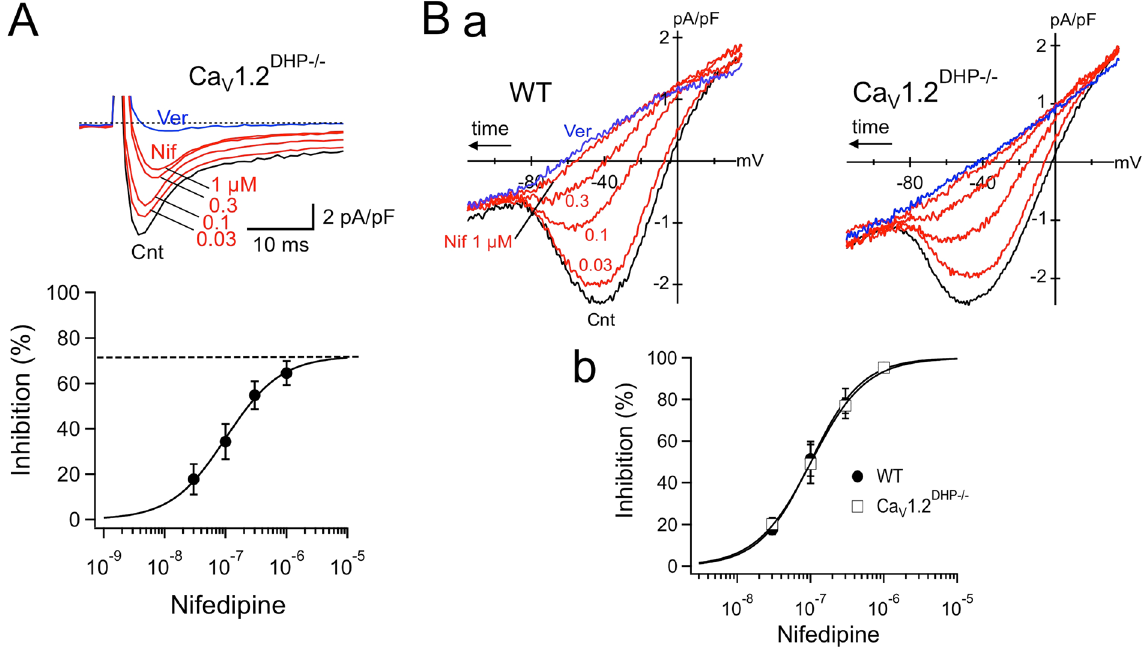
Figure 5. Sensitivity of I Ca,L and I st to nifedipine in SAN cells from Ca V 1.2 DHP − / − mice. ( A ) I Ca,L inhibition by nifedipine in Ca V 1.2 DHP − / − SAN cells. (a) Superimposed sample traces of I Ca,L elicited by depolarization to − 10 mV from a holding potential of − 50 mV in TEA + -substituted, Na + -free Tyrode solution (control, black ) and during nifedipine application at various concentrations (0.03–1 µ M, red ), and after subsequent addition of 3 µ M verapamil ( blue ). (b) Concentration-dependent inhibition of I Ca,L by nifedipine. Inhibition is expressed as the percentage of residual I Ca,L inhibited by nifedipine relative to control I Ca,L . Data are mean ± S.E.M. of four experiments. The smooth curve represents the least squares fit of data points using the Hill equation, yielding a maximal current response of 72%, IC 50 of 101.7 nM and Hill coefficient of 0.97. ( B ) Effects of nifedipine on I st in wild-type and Ca V 1.2 DHP − / − SAN cells. (a) Superimposed I – V relationships of I st obtained by voltage ramp in wild-type ( left ) and Ca V 1.2 DHP − / − ( right ) SAN cells in the control 0.1 mM [Ca 2 + ] o solution (control, black ), during exposure to various concentrations of nifedipine (0.03–1 µ M, red ), and after application of 3 µ M verapamil ( blue ). (b) Concentration–response relationship of I st inhibition by nifedipine in wild-type ( closed circles ) and Ca V 1.2 DHP − / − ( open squares ) SAN cells. Data are mean ± S.E.M. of four independent measurements. The line represents the fit of the Hill